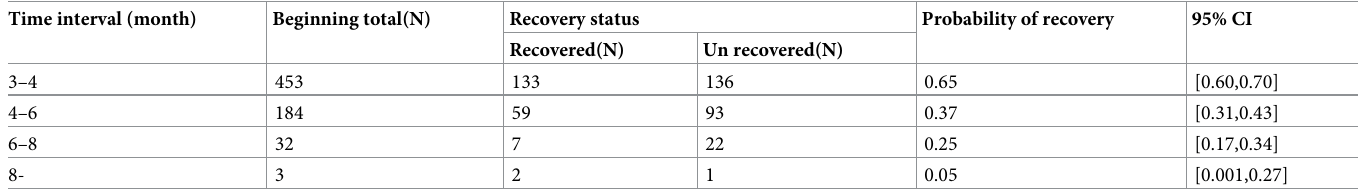
Table 5. Life table for recovery rate of under nourished HIV positive adults treated with RTUF at 3, 4, 6 and 8 months at Debre Markos referral hospital from July of 1 st , 2015 –December of 31 st , 2017. Time interval